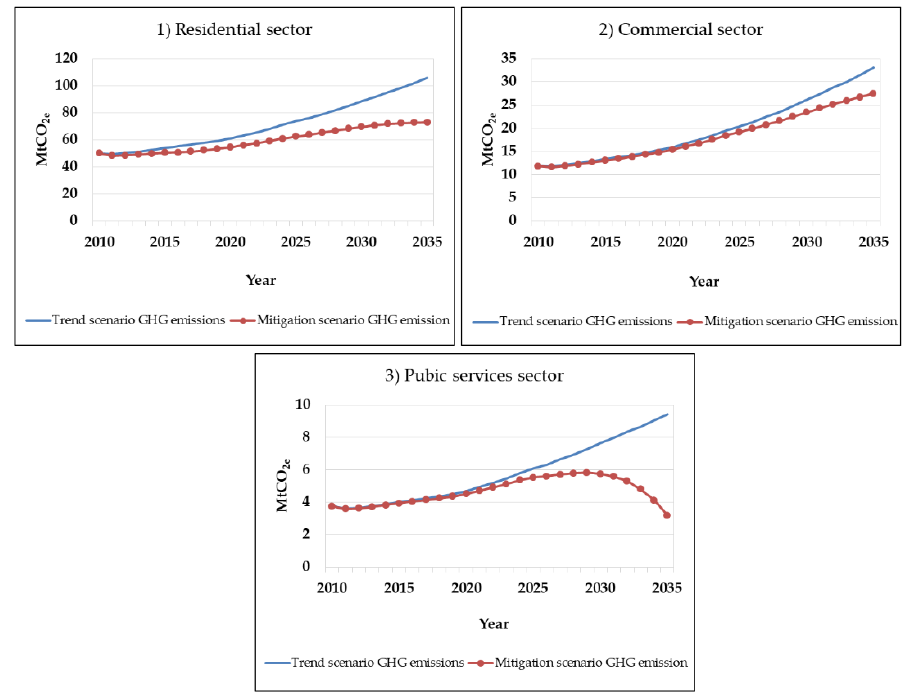
Figure 5. GHG emissions in the trend scenario and in the alternative scenario by sector. Source: Own elaboration.